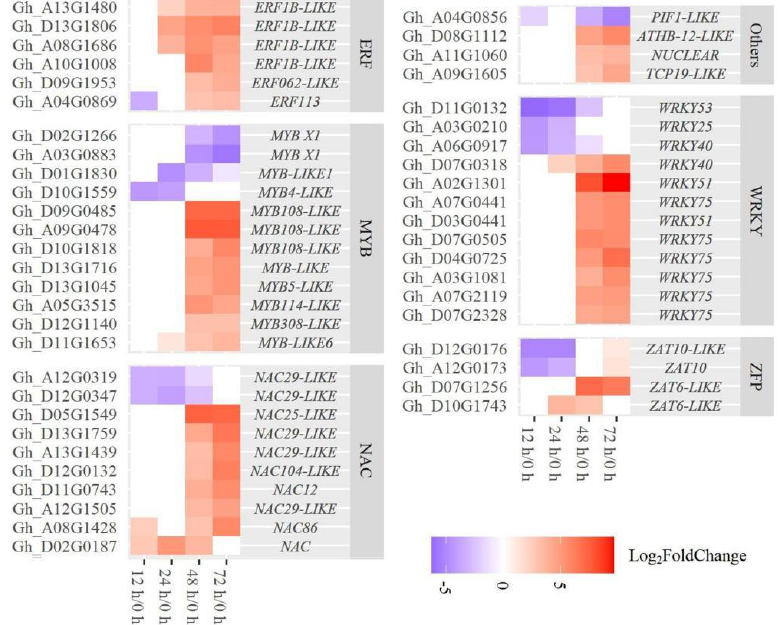
Figure 13. TDZ regulates the transcription factors genes in AZ. DEGs were determined between 12 h and 0 h, 24 h and 0 h, 48 h and 0 h, 72 h and 0 h, respectively. The DEGs were controlled by FDR < 5% and |log2Fc| ≥ 8 at least from two consecutive time